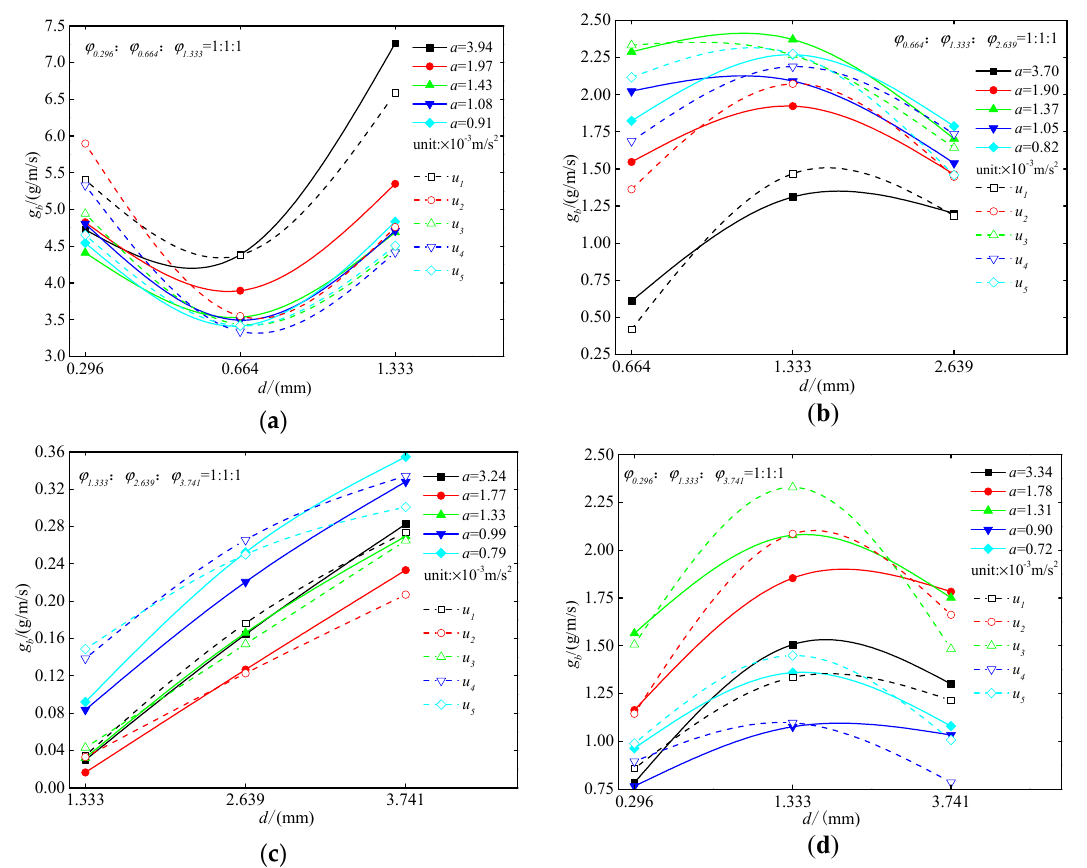
Figure 10. Sediment transport rate of different non-uniform sand groups under unsteady flow (solid scatters denote unsteady flow, and open scatters indicate steady flow corresponding to the same transport). ( a ) d 50 = 0.664 mm; ( b ) d 50 = 1.333 mm; ( c ) d 50 = 2.639 mm; and ( d ) d 50 = 1.333 mm.